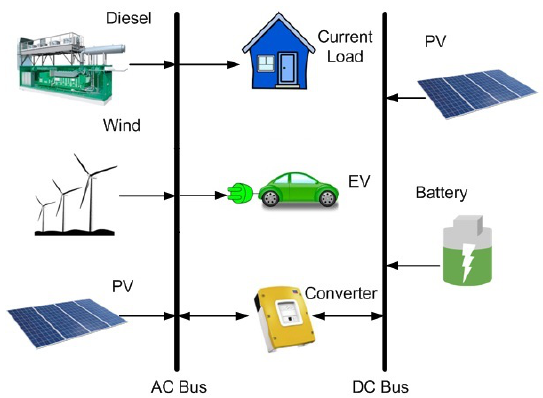
Figure 3. Configuration of the